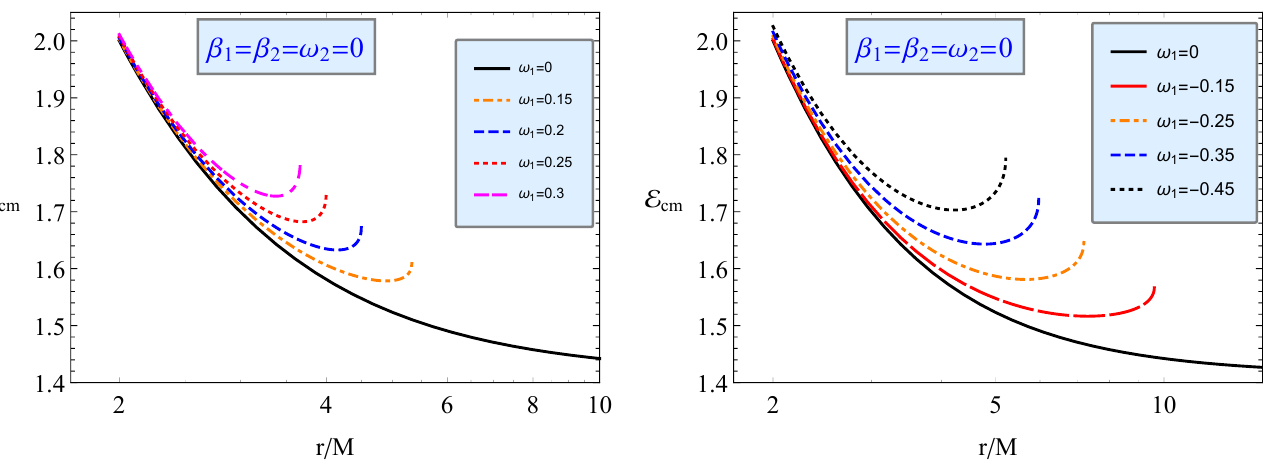
Figure 9. Figure shows the radial dependence of E cm of the collisions of two positively and negatively charged particles with electrically neutral particles on the different values of the